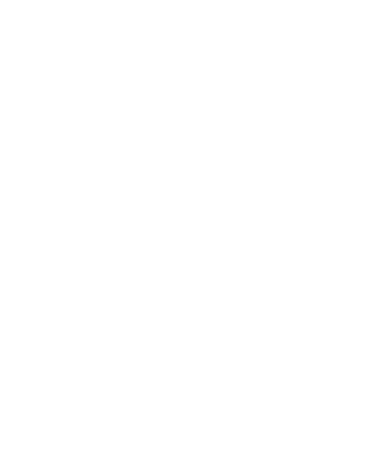
Fig. 11. SiO 2 (wt%) vs Al 2 O 3 (wt%) diagram showing a possible source for the